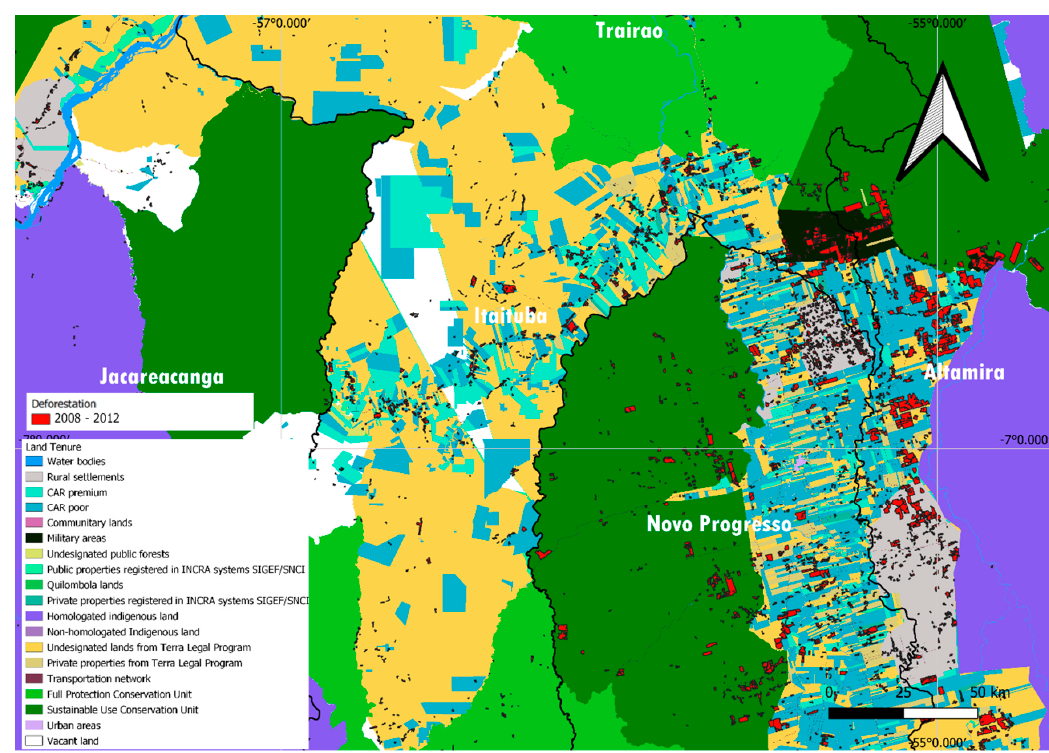
Figure 3. Deforestation in the west of Pará from 2008 to 2012.